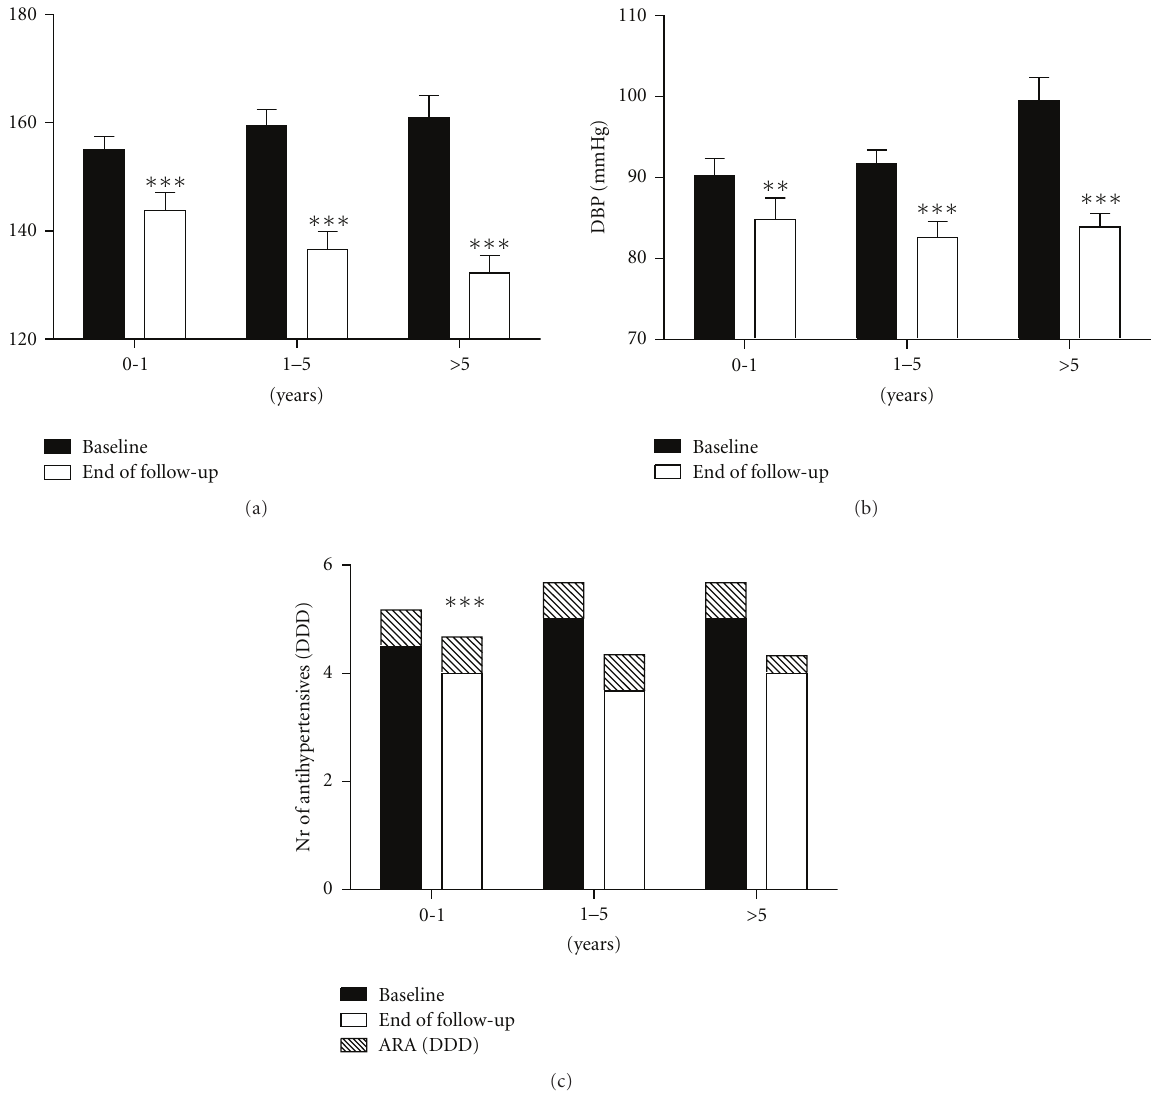
Figure 3: Systolic (SBP) (a), diastolic (DBP) (b) blood pressure and medication use (defined daily dose, DDD) (c) at baseline and end of followup after stratification for followup duration for patients with essential hypertension (Figure 3) and primary aldosteronism (Figure 4). Indicated in (c) is the DDD for the aldosterone-receptor antagonist (ARA). For baseline, this is added up to total DDD; at the end of followup, this is part of the total DDD since ARA was started at baseline. Di ff erences were tested with paired t -test for SBP and DBP and Wilcoxon Signed Ranks test for DDD (DDD without ARA at baseline versus DDD including ARA at the end of